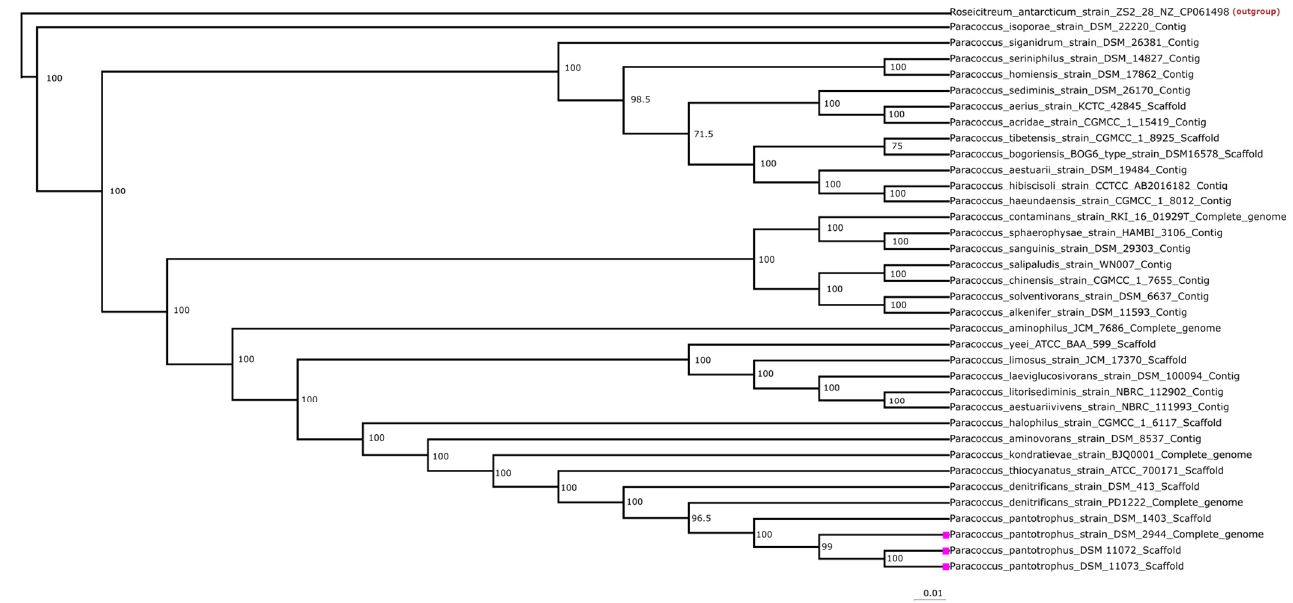
Figure 1. Rectangular phylogenetic tree of Paracoccus , comprising 35 Paracoccus genomes. A dataset of 992 genes per genome, 38,688 in total, was used. All genomes are annotated with genus, species, and assembly level, providing a holistic overview of the genome quality under study. The dataset has 361,894 amino acid residues and 14,113,866 in total. For the out-group and the starting point of the calculation, the genome of the bacterial strain Roseicitreum antarcticum ZS2-28 was chosen due to the high similarity to the Paracoccus genome (94.35% 16S identity). The genomes marked with pink boxes highlight the three strains used in this study and show the close phylogenetic similarity. Strains DSM 11104 and DSM 65 are not shown due to missing genomic data. The tree topology was validated using 100 bootstrapping with 200 iterations, as implemented in the Phylip package. Most branches showed 100% bootstrap support; the values are displayed in the image. The scale at the bottom depicts evolutionary distance.